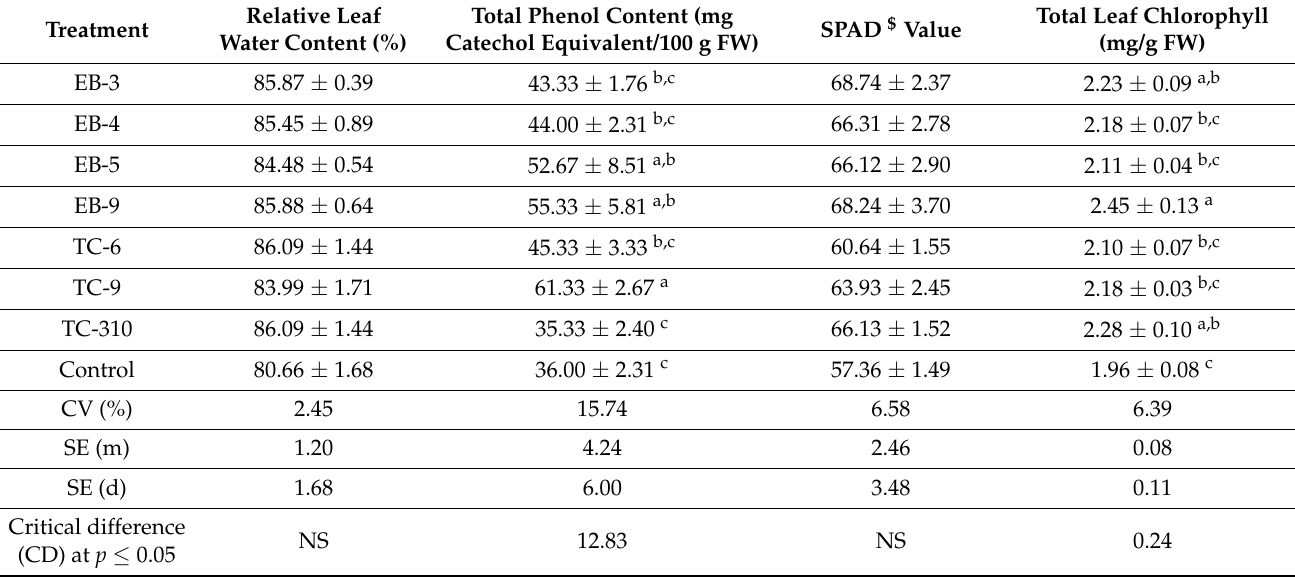
Table 4. Physiological and biochemical response of pomegranate plants upon endophytic bacterial